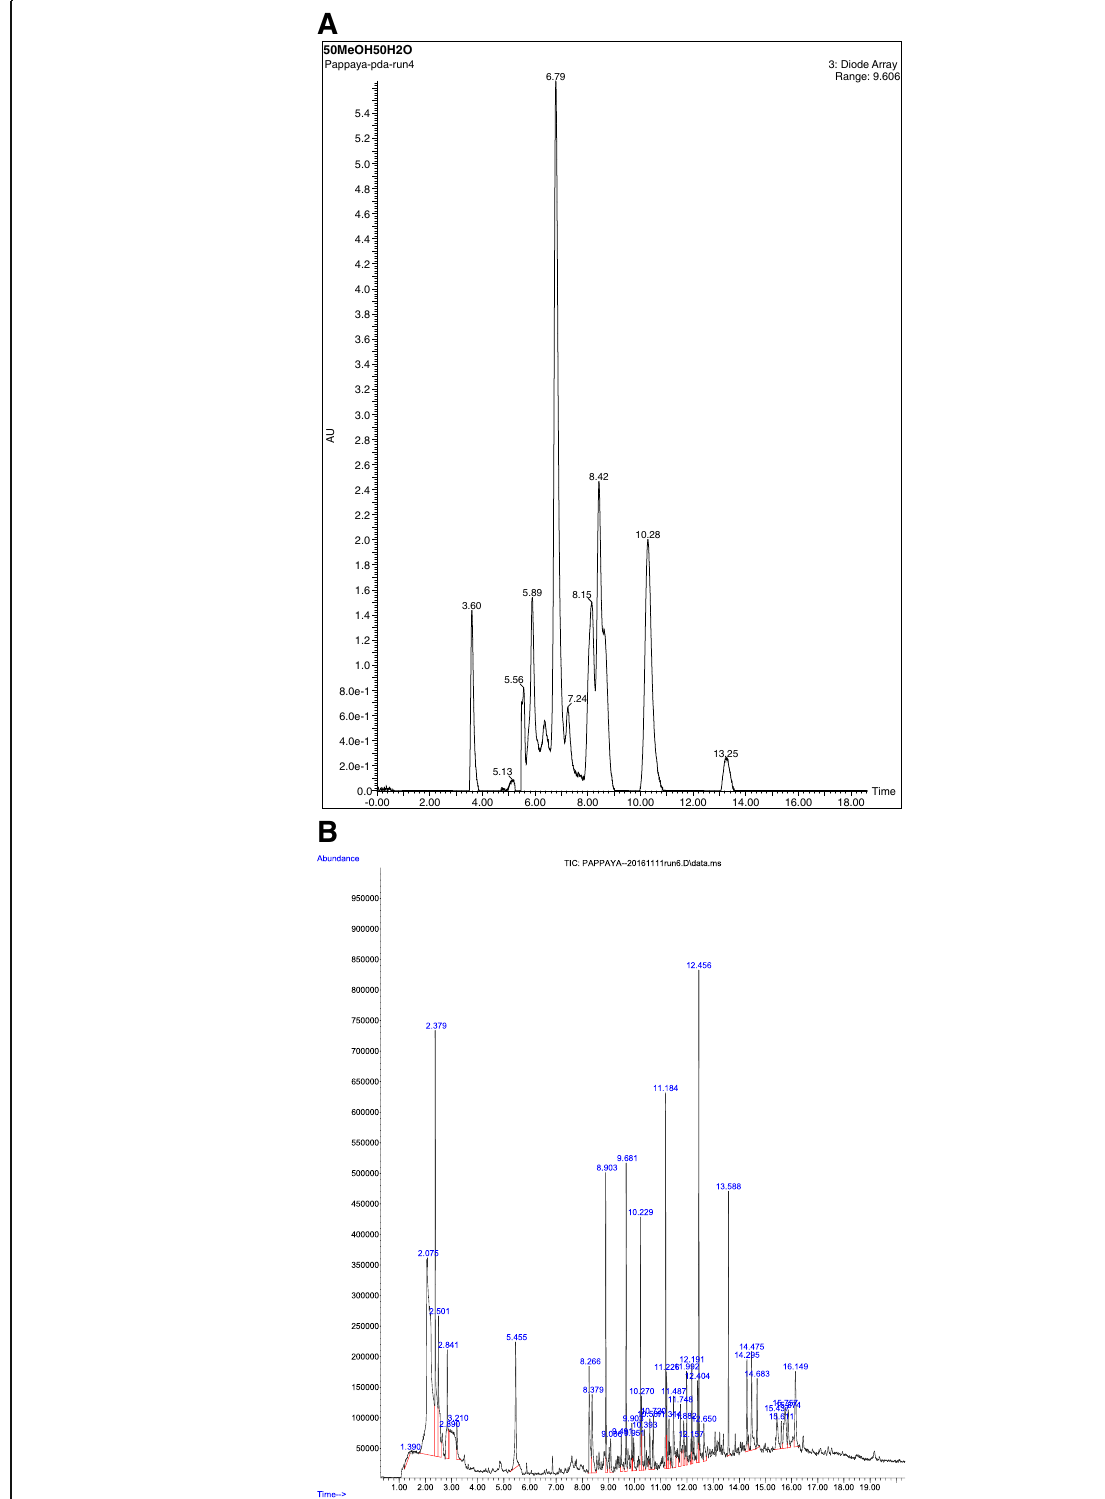
Fig. 7 Chemical Profiling of the MLCC. a LC-MS chromatogram, b GC-MS chromatogram of the MLCC. Molecular weights, peak retention times and wave length of the peaks are